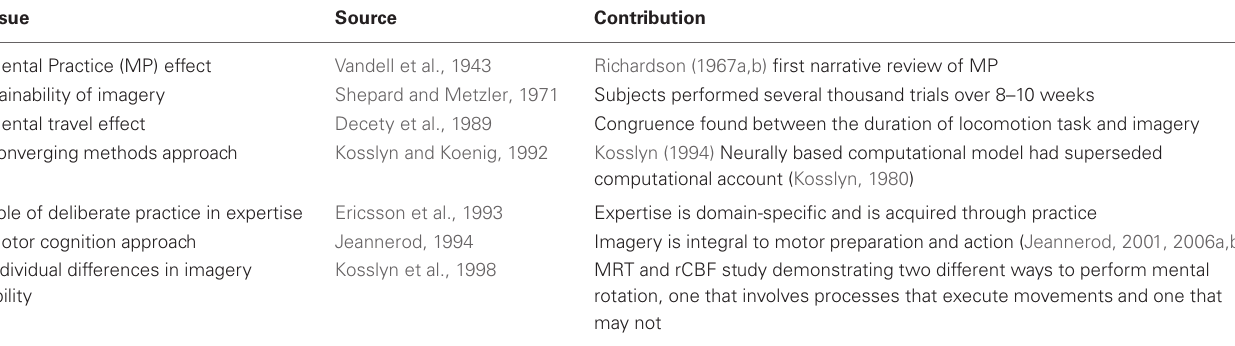
Table 2 | Antecedents to the strength-based approach in mental imagery